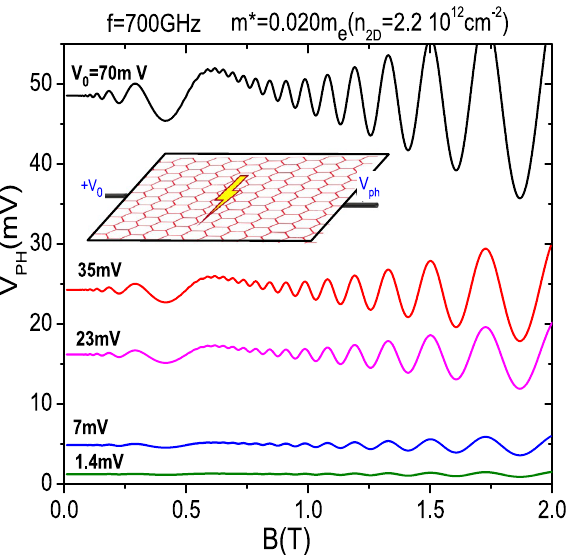
Figure 3. Calculated photovoltage vs B for different values of the external positive voltage, 0.020 m voltage is kept constant giving a m ∗ e . The radiation frequency is 700 GHz and T = = upper to the lower curve the external voltage is gradually decreased. For the lowest value the oscillations, both MIRO-like and SdH, are practically washed out.